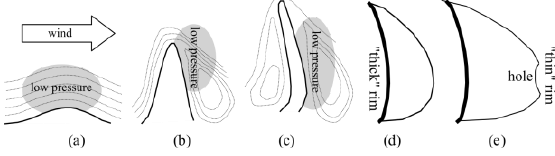
Fig. 5. Schematic diagram of the formation and fragmentation of a bag. (a) Formation of the initial disturbance, (b) increase of the initial disturbance, (c) sail-shaped disturbance, (d) formation of the bag, (e) rupture of the bag. The thin dotted lines are the streamlines in the reference frame following the elevation of the water surface.